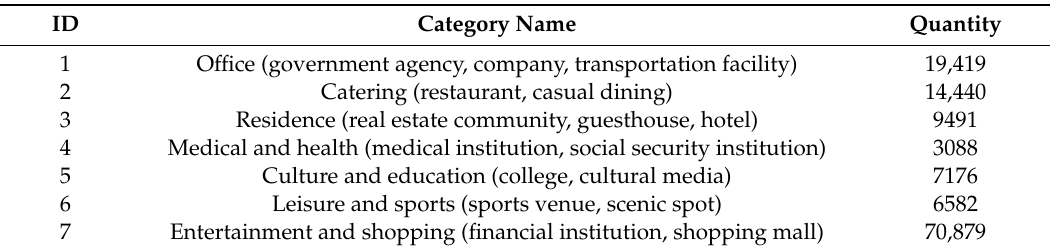
Table 1. Point of interest (POI)